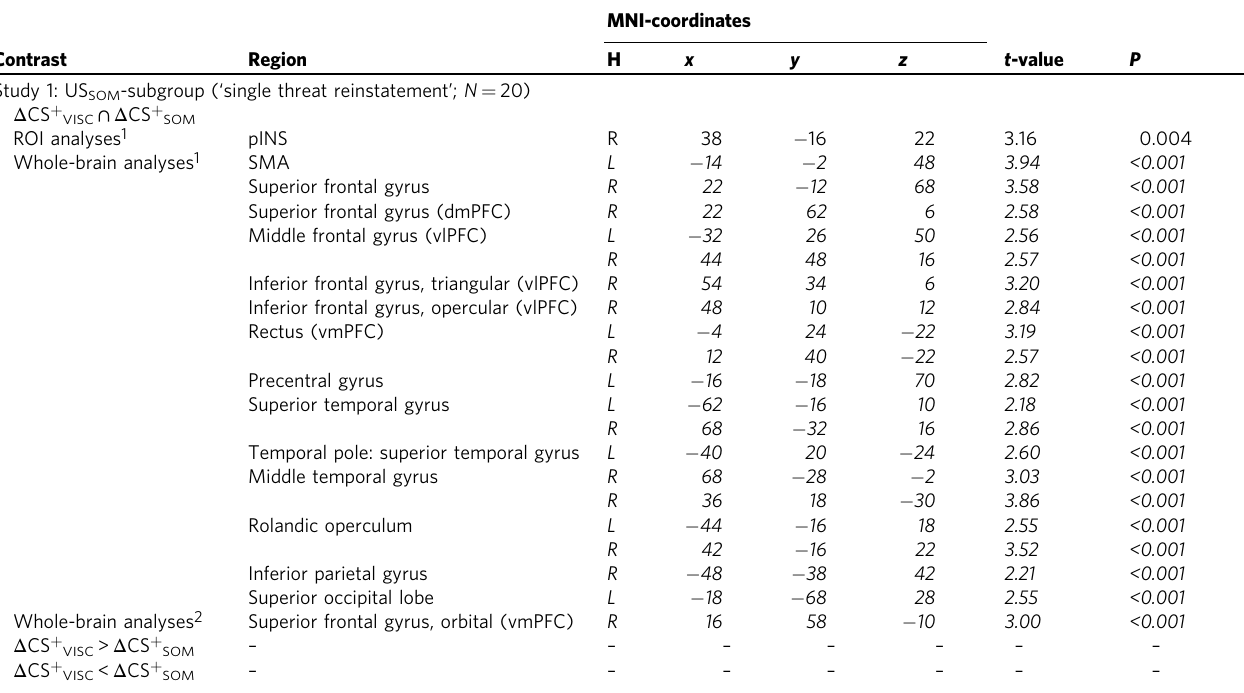
Table 5 Neural activation induced by cues (CS) predicting interoceptive versus exteroceptive threats during reinstatement-test after somatic single threat reinstatement in study